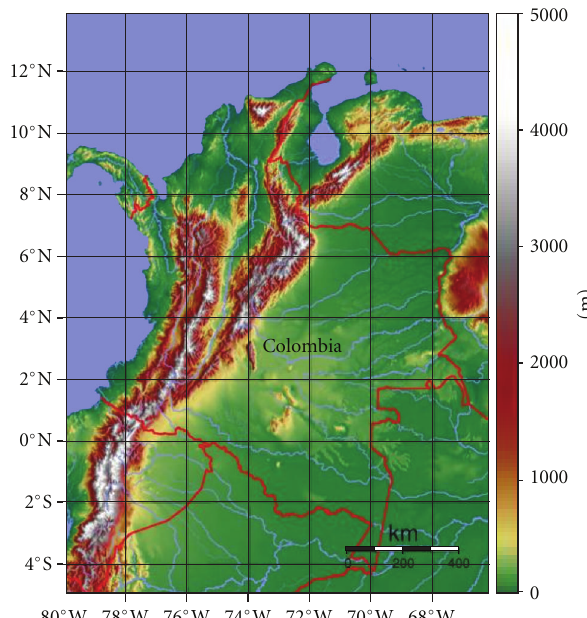
Figure 1: Topographic characteristics of Colombia. Terrain ele- vations are color banded in 1,000 meters intervals. Adapted from http://en.wikipedia.org/wiki/File:Colombia